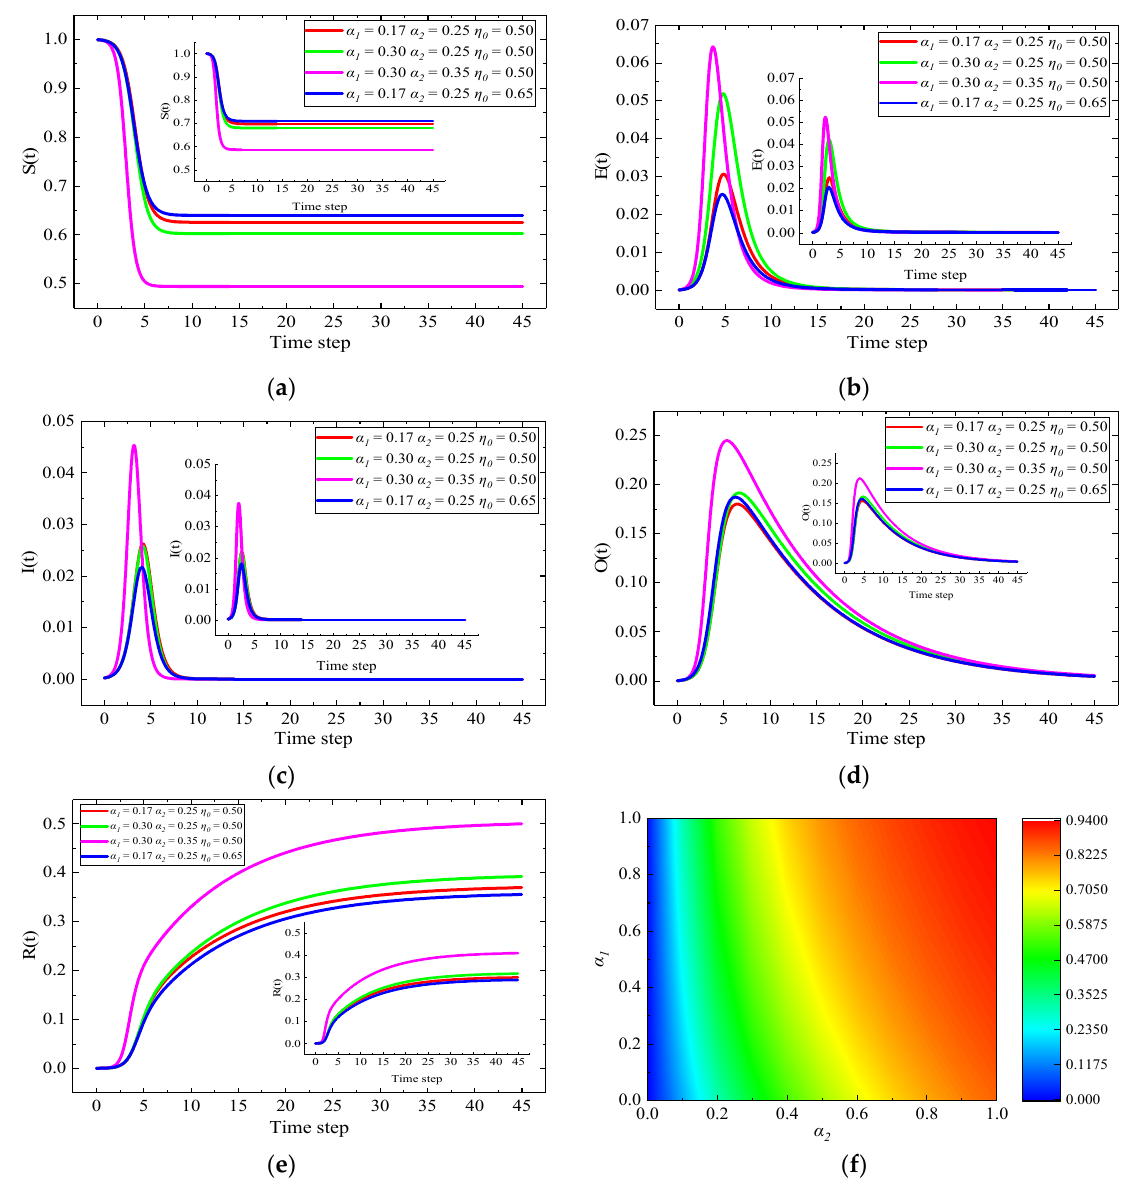
Figure 6. ( a – e ) show the density evolution curves of ignorant people, hesitators, spreaders, rumor debunkers, immunizers in the two types of networks with different hesitating situations (the large figure represents the simulation on the WS network and the small figure represents the simulation on the BA network); ( f ) shows the changes of immunizers in the WS network with α 1 and α 2 when time step, t = 45.